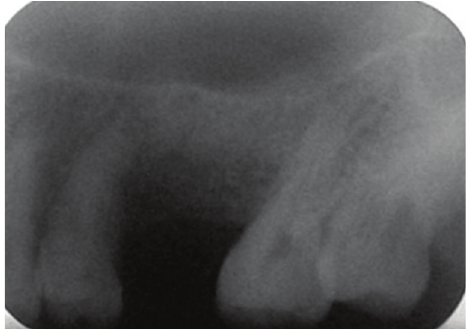
Figure 6: Panoramic view showing a radiolucency with haziness present on the right maxilla, zygomatic arch, anterior wall, and floor of the maxillary sinus were not clearly demarcated.